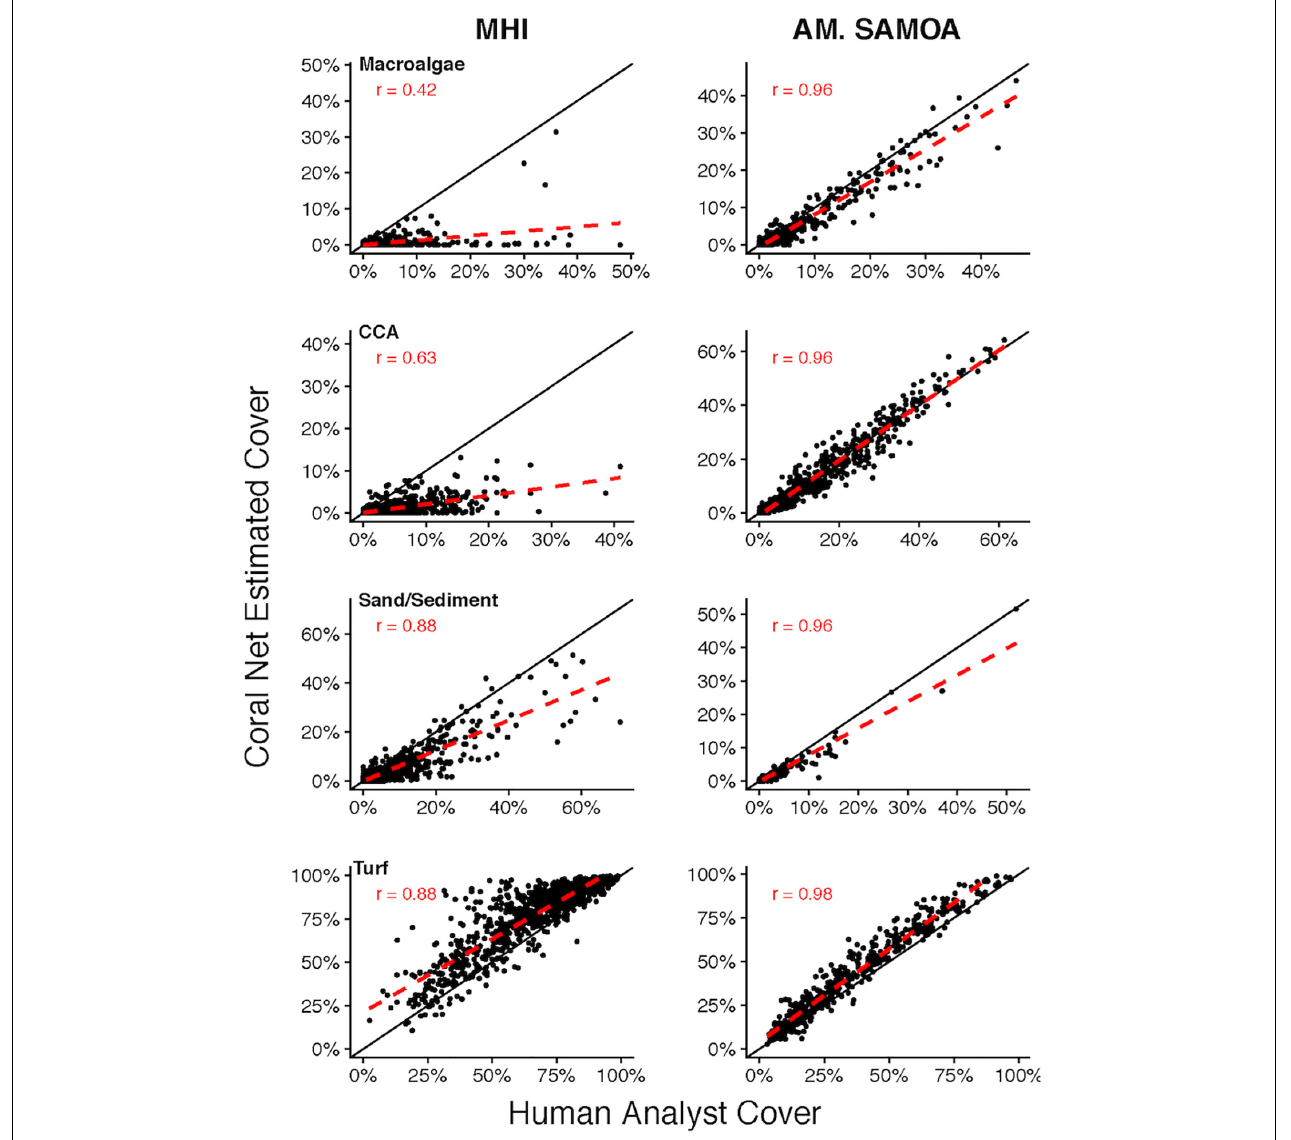
FIGURE 5 | Site-level coral cover of non-coral functional groups by human analyst and CoralNet. Figures on the left-hand side show MHI site data, and those on the right represent American Samoa sites. Each point denotes a single site; the solid black line is the 1:1 line, and the dashed red line is a linear fit of the point data. MHI CoralNet estimates were derived from the “BASE-HABITAT” classification. American Samoa CoralNet estimates were derived from the “BASE” classification ( Supplementary Table S2 ). “r” values are Pearson’s correlation coefficients. Total number of sites is 598 for MHI, and 468 for American Samoa. Correlations are significant ( p < 0.0001) in all